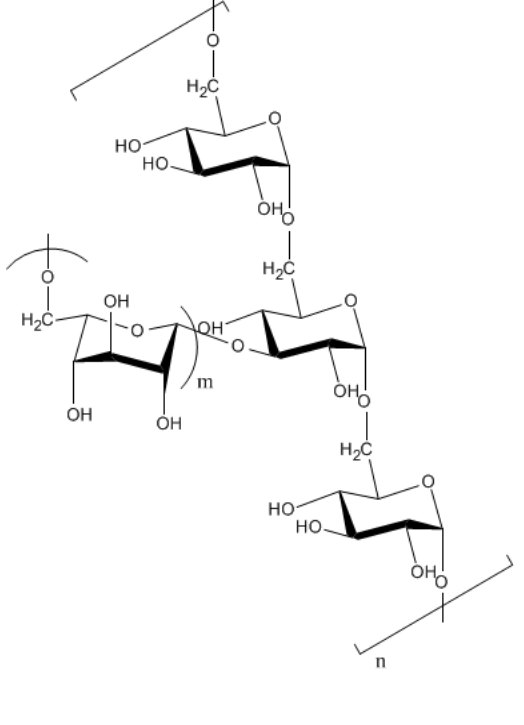
Figure 1. The structure of dextran with branching at C3